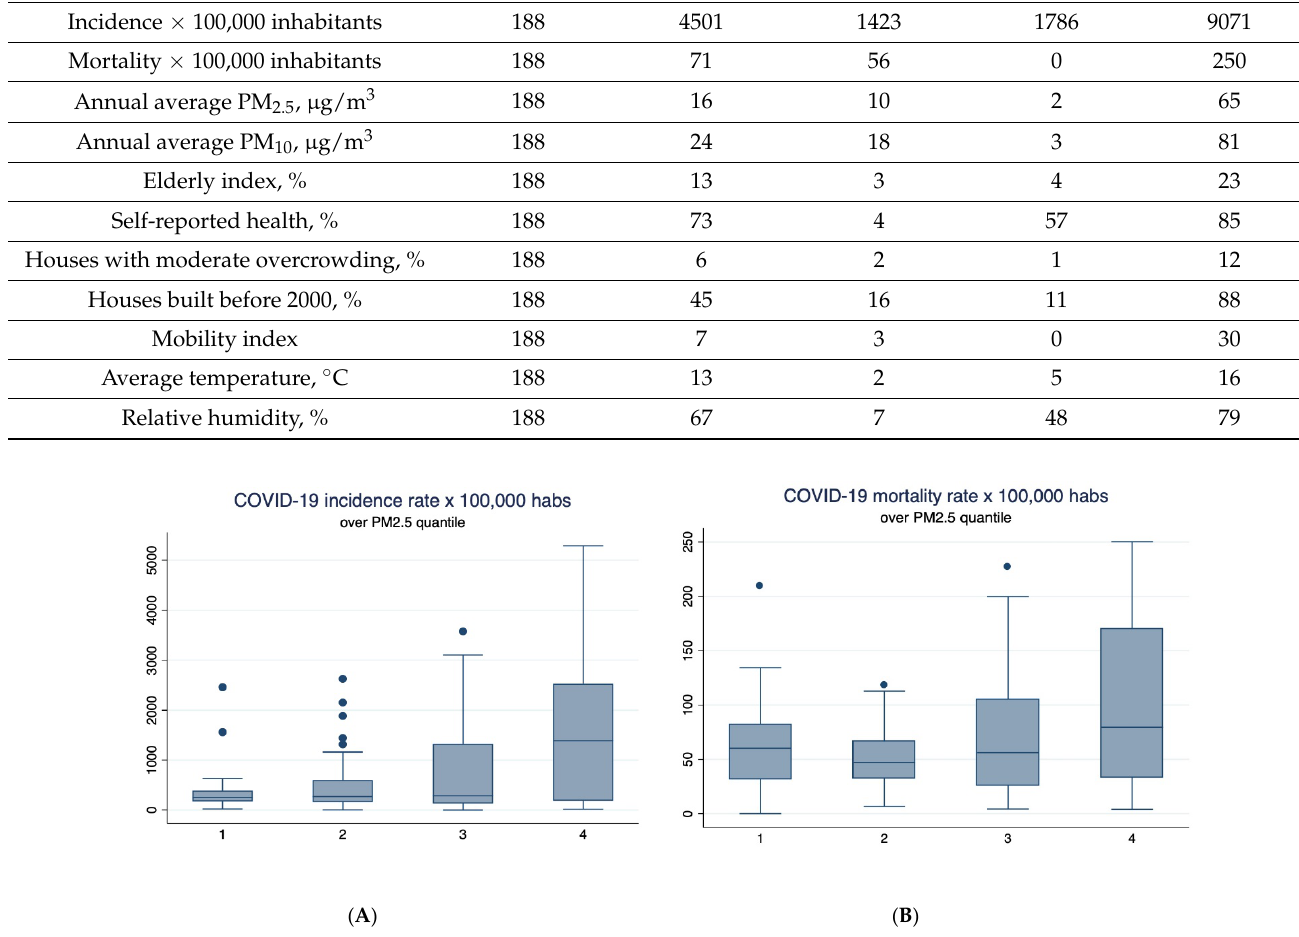
Table 1. Health and socio-environmental statistics in 188 Chilean communes, 2020.